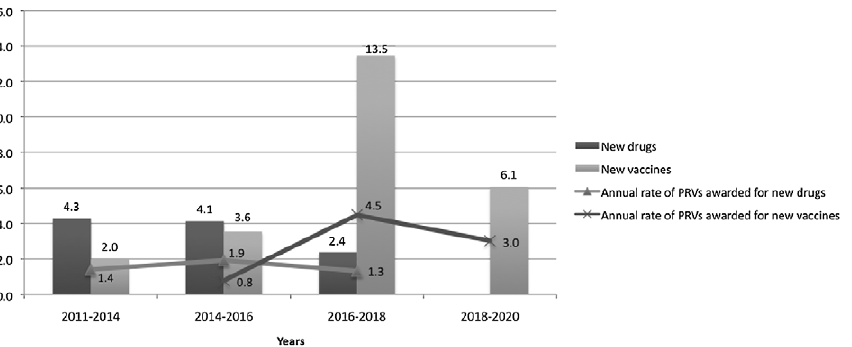
Figure 3. Estimated approvals of FDA drugs and vaccines for NTDs. Prediction model used to calculate the total number of expected PRVs, as well as the average annual rate of how many PRVs will be awarded. The model assumes a 100% success rate for approval by FDA of products already approved abroad. (The analysis adjusted for situations where one product approval would deem another ineligible. For example, SM14, a recombinant/purified protein vaccine, is currently under development for both schistosomiasis and fascioliasis. If it were to be approved for schistosomiasis, it would make approval for the indication of use against fascioliasis ineligible. Therefore, SM14 was counted as one product for the purposes of predicting the number of PRVs.) Similarly, the model assumes each individual product in development will yield one product. For malaria vaccines, for example, this may not be the case as many believe that these parts would be combined into one product before licensure. See study limitations for further